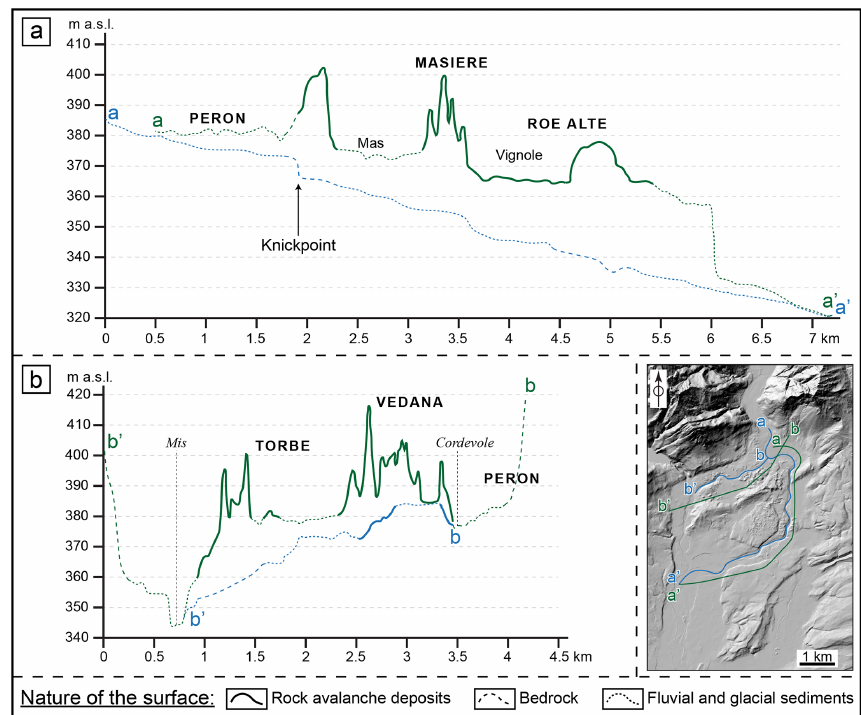
Figure 7. Curvilinear topographic profiles (10 × vertical exaggeration) showing the relationship between the bigger incisions and the external main surfaces related to the rock avalanche and the post-event evolution. Profiles correspond to the present course of Cordevole creek (blue line in a ) paired with the main topographic surfaces on its left bank (green line in a ) and the main incision passing through the Torbe and Vedana sectors (blue line in b ) paired with the main topographic surfaces on its left side (green line in b ). Traces of the profiles are shown in the small DTM (open data released by Regione Veneto: http://idt.regione.veneto.it/app/metacatalog/, last access: 17 October 2019), which corresponds to Fig.